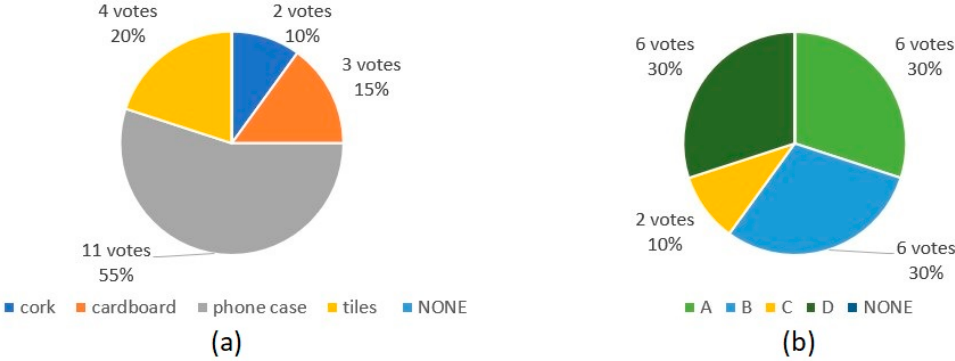
Figure 8. ( a ) Volunteers’ perception of the virtual texture displayed on the touchscreen for test 3. ( b ) Volunteers’ perception about the canvas that better represented the physical texture for test 3. According to survey questions from Appendix A.